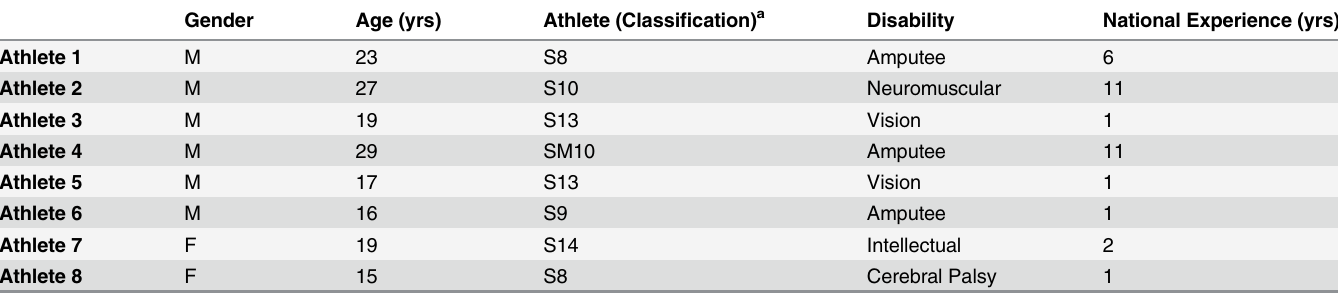
Table 1. Athlete